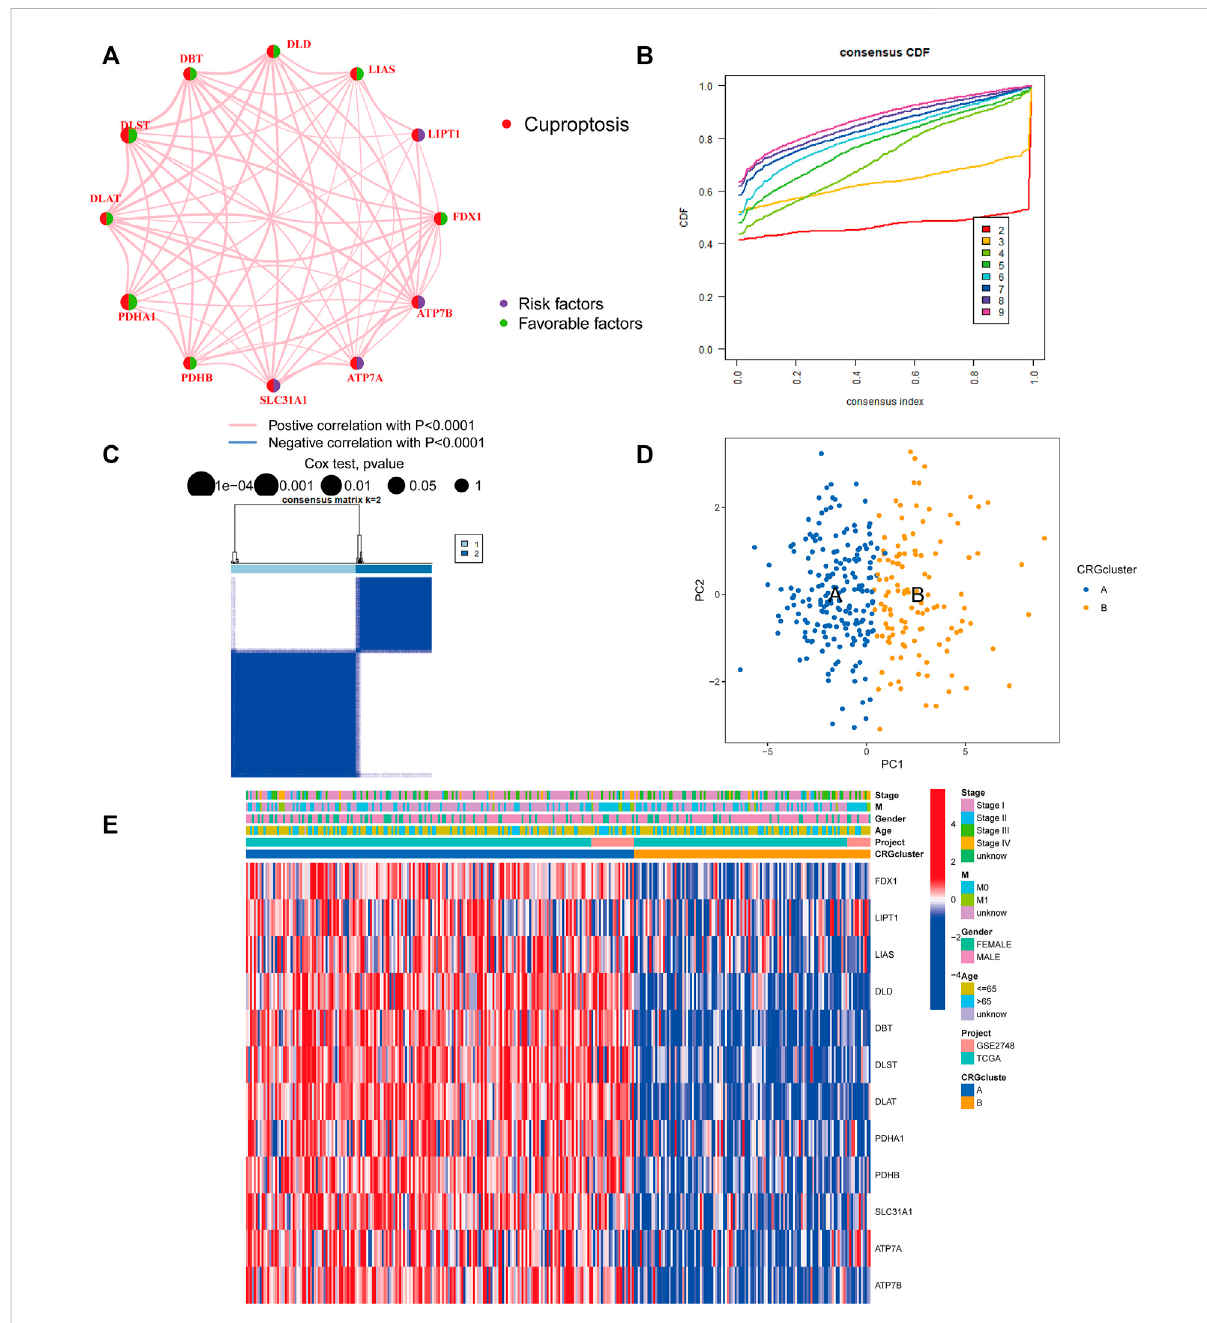
FIGURE 2 Identi fi cation of cuproptosis subclusters in PRCC. (A) Interactions among CRGs in PRCC. Greater PRCC predictive in fl uence is shown by larger circles. The protective factor is represented by green, and the risk prognostic factor by the dark blue within the circle. (B) Consensus clustering cumulativedistributionfunction(CDF)curvewhenK=2 – 9. (C) TheconsensusclusteringmatrixforCRGmodi fi cationpatterns.AtK=2,thesamples are partitioned with reasonable stability. (D) Principal component analysis (PCA) of two clusters. Blue indicates CRG cluster A, whereas orange representsCRGclusterB. (E) TheheatmapdepictstheexpressionofCRGsandclinicopathologiccharacteristicsindifferentsubclusters.Reddenotes high CRG expression and blue, low CRG